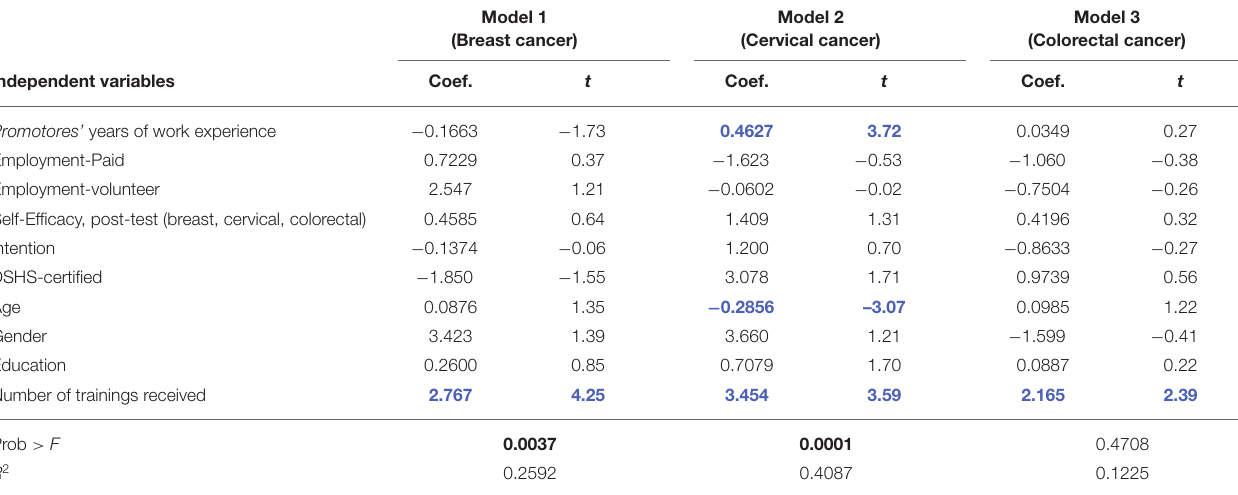
Model 1 (Breast cancer)